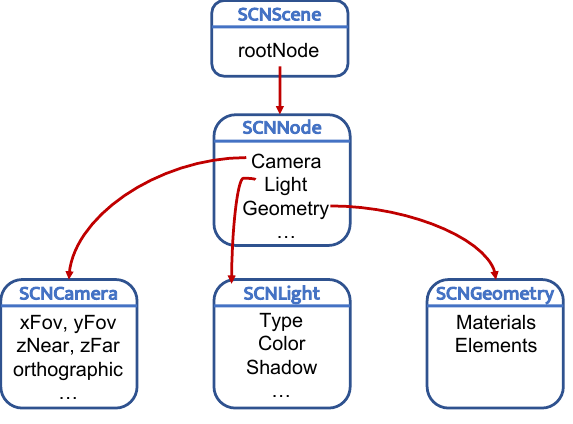
Figure 3. High-level